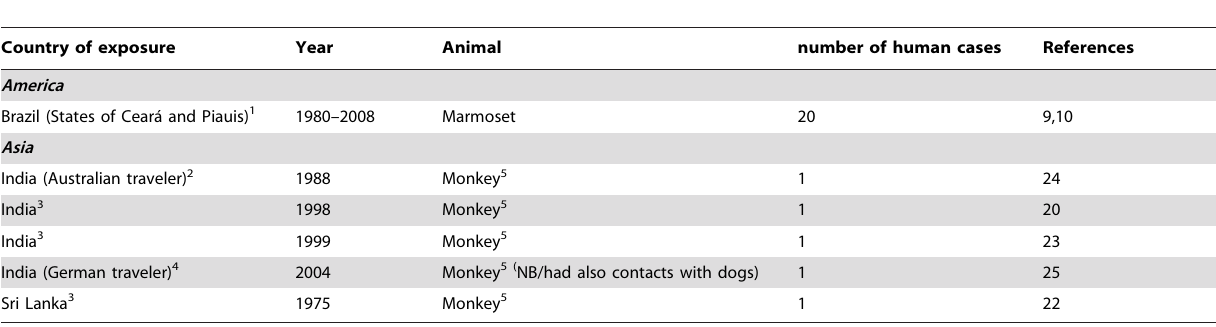
Table 1. Human rabies 1 cases following nonhuman primate-related injuries.